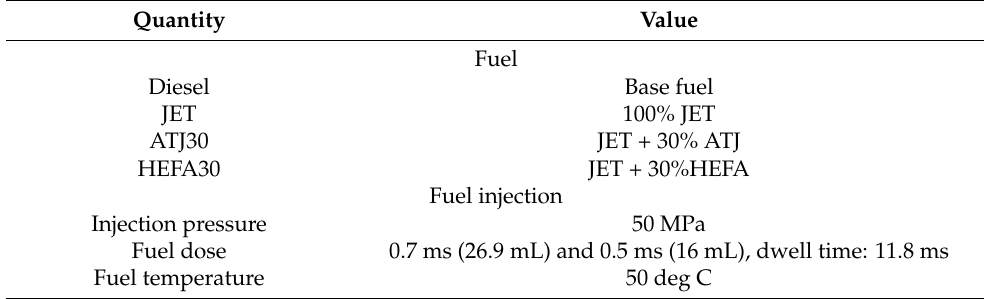
Table 3. Experimental conditions.